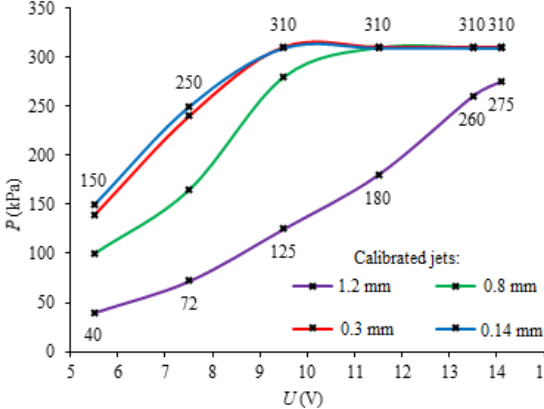
Figure 9. The dependence of the change in the current consumption rate of the EFP on the change in the supply voltage when using calibrated flow passage jets (0.14 mm...1.2 mm) connected in parallel to the fuel supply line